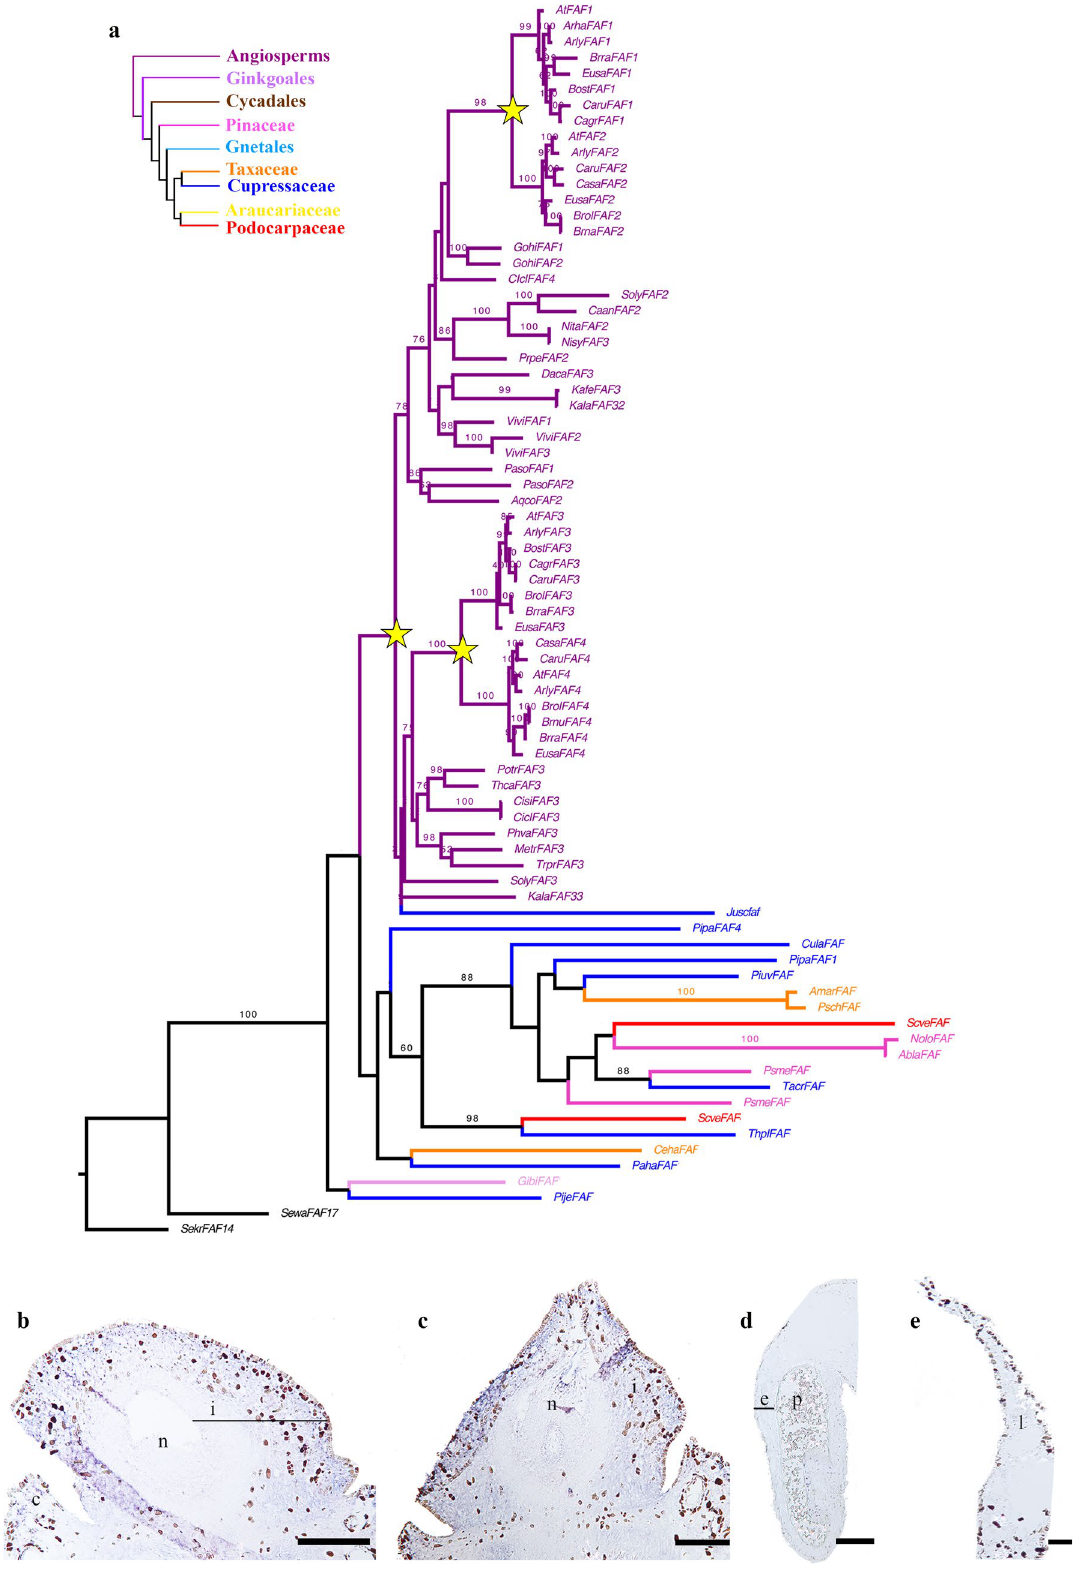
Figure 6. FANTASTIC FOUR gene family evolution and expression in Ginkgo . (a) Maximum Likelihood (ML) analysis for FAF homologues across seed plants. Yellow stars indicate the three large scale duplication events detected. One before the diversification of angiosperms giving rise to the clades FAF1/2 and FAF3/4 . And each clade has undergone one more duplication specific to Brassicaceae. (b–e) In situ hybridization for GibiFAF . (d) Pollen cone. (e) Leaf. e endothelium, i integument, l leaf, n nucellus, p , pollen. Scales: 75 μm ( a,b ); 100 μm ( d,e